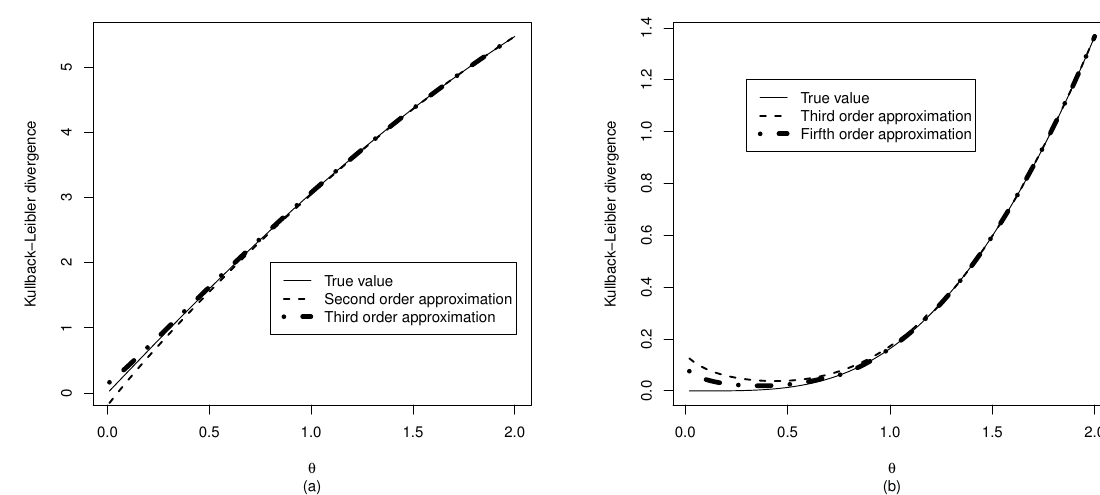
Figure 4. Kullback–Leibler divergence from the half normal for a range of values of θ = µ with σ = 1 ( a ) and σ = 5 ( b